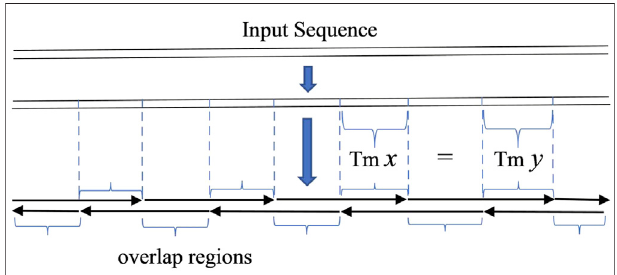
FIGURE 1 | Scheme of gapless PCR or ligase chain reaction assembly. Theinputsequenceisregardedastheserialconnectionoftheoverlapregions of oligonucleotides.